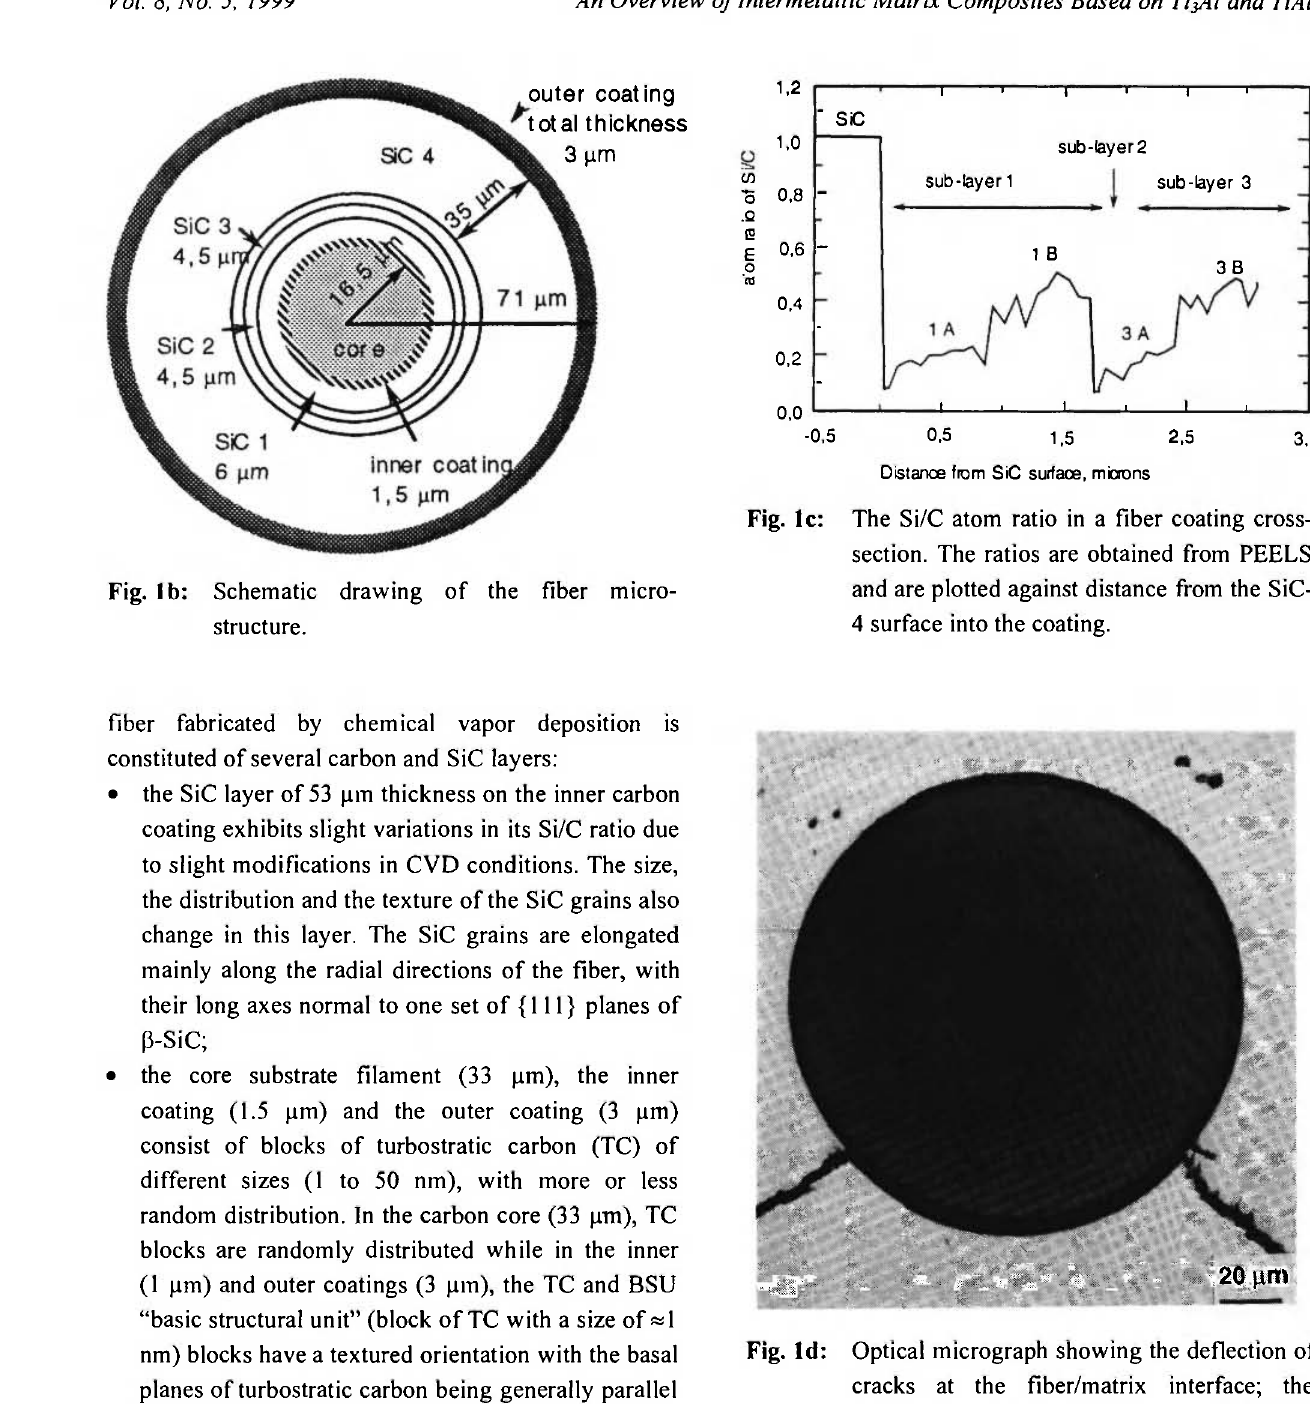
different sizes of SiC particles embedded in these, and the different Si/C ratios. These two sublayers are separated from each other by a thin sublayer 2 (0.1 μιτι) containing no or a very low fraction of